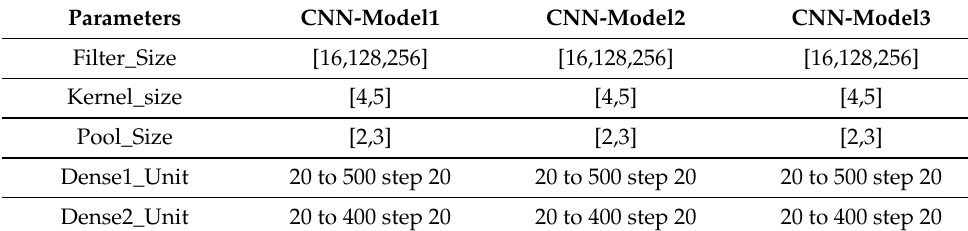
Table 2. The hyperparameter values of the CNN